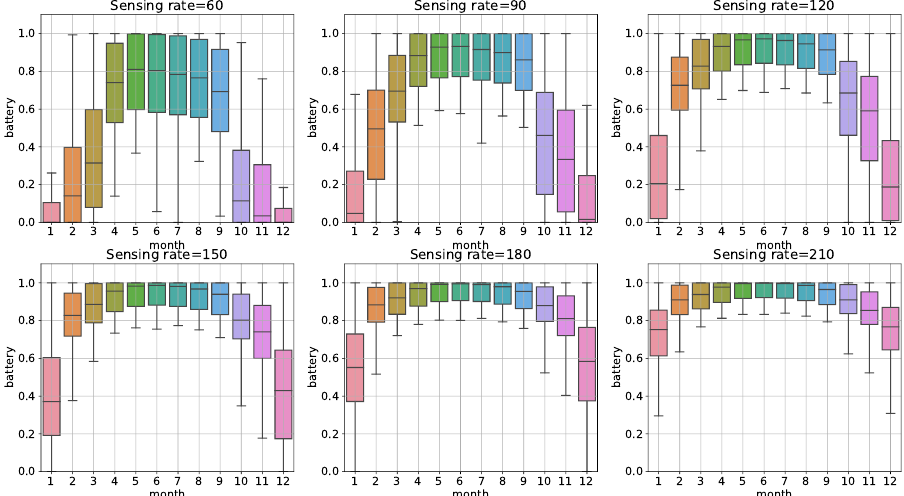
Figure 3. Battery levels of the device for various constant sensing rates. Colors of the boxes are related to the mean value of battery